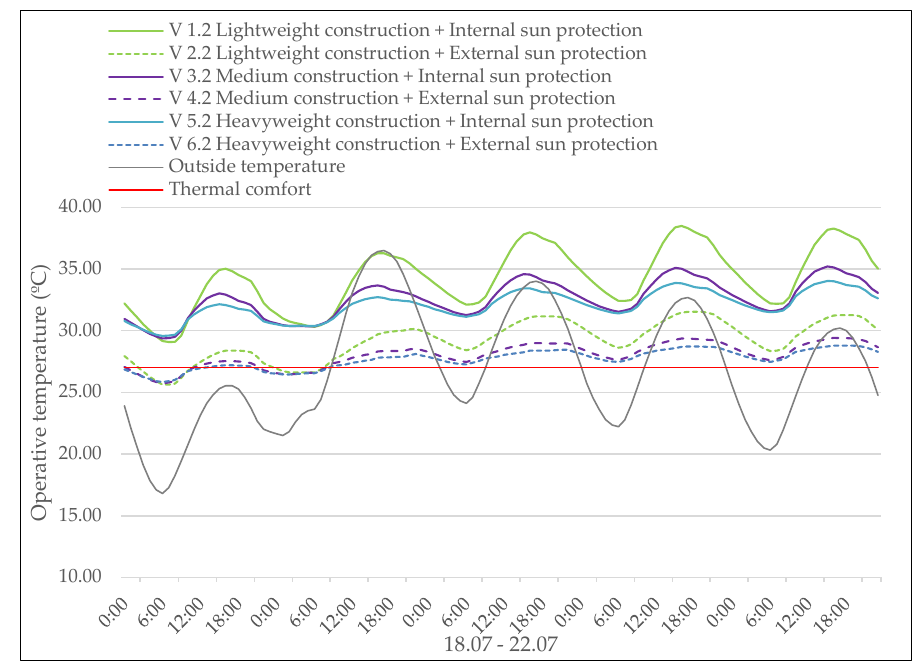
Figure 6. Future climate scenario — Variants of thermal mass and sun protection, based on [33].